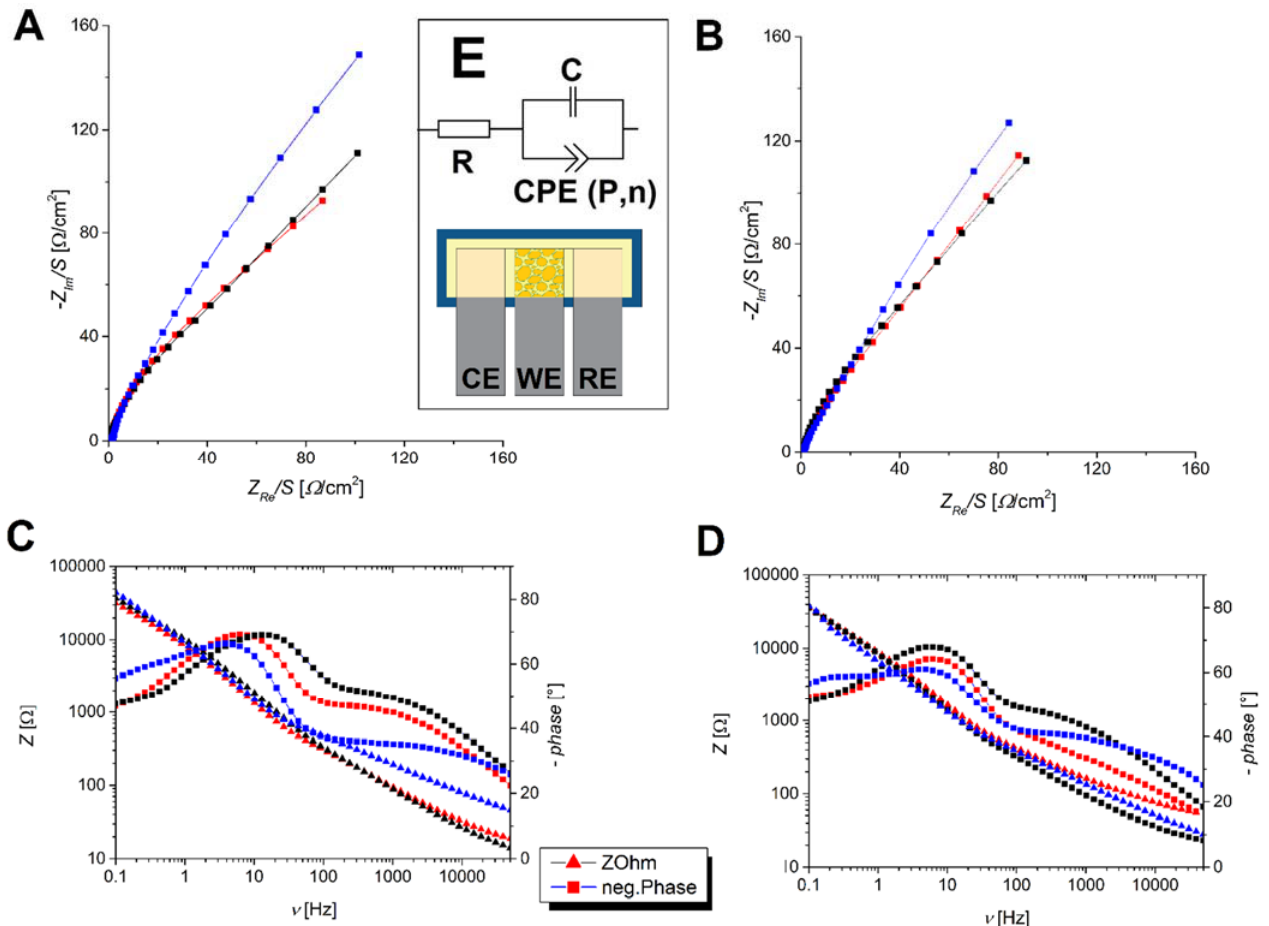
Figure 6. Nyquist diagrams of investigated biosensors showing a response for aflatoxin B1 ( A ) and isoniazid ( B ), along with Bode diagrams for aflatoxin B1 ( C ) and isoniazid ( D ). For Bode diagrams, triangles represent total impedance |Z|, while squares represent phase change. Both biosensors that had applied hepatotoxin are marked with a black label, where the control measurement is marked with the blue label and the biosensor without any attached cells is marked with the red label. Units are Ω /cm 2 where the impedance response is normalized for the surface of the WE. A schematic of the biosensor with electrode placement ( E bottom) along with fitted circuit for EIS analysis ( E top) is also shown.